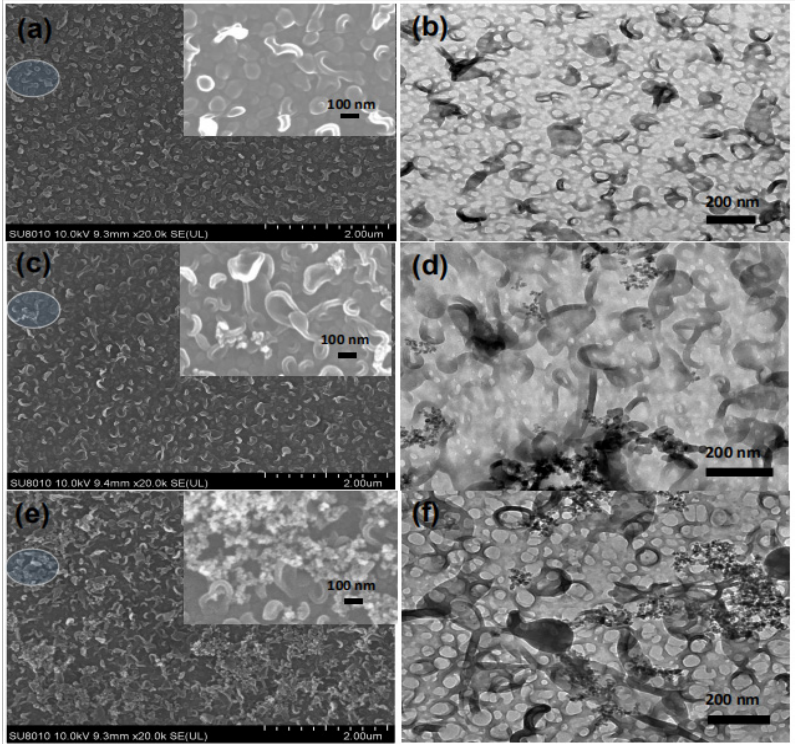
Figure 4. SEM ( left ) and TEM ( right ) images of membranes with different concentrations of R812S NPs: ( a , b ) no NPs, ( c , d ) 0.02% ( w / v ), ( e , f ) and 0.1% ( w / v ).